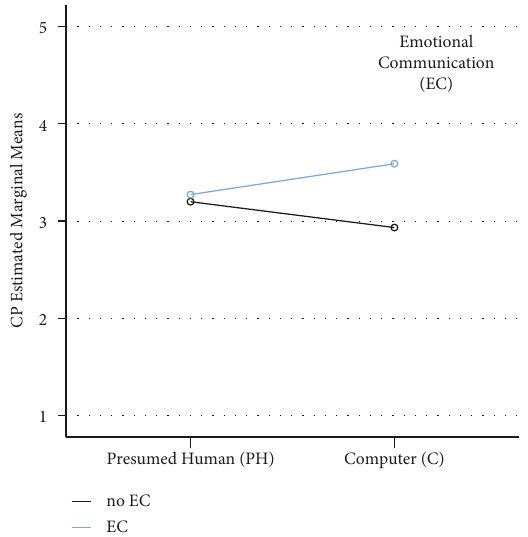
Figure 4: Copresence (CP) estimated marginal